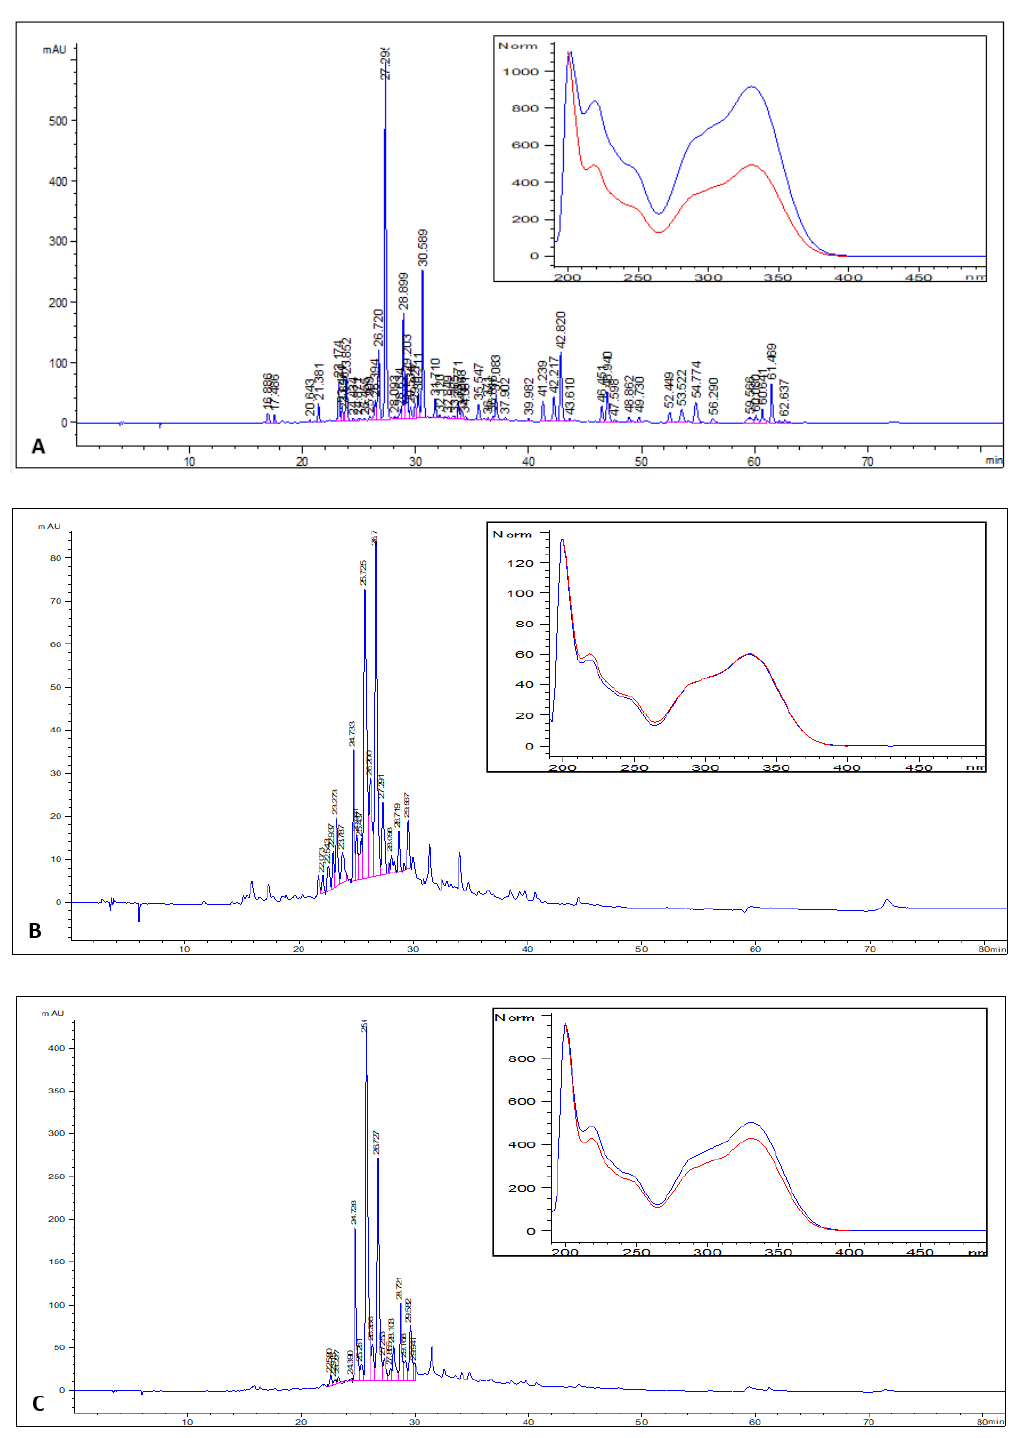
Figure 3. HPLC-PDA (photodiode array detector) chromatograms of the chemical profiles of polyphenols occurring in the studied extracts of leaves ( A ), stems ( B ), and roots ( C ). For each extract, the insert presents the PDA spectrum of the major peak and the PDA spectrum of the acteoside reference (in red) .